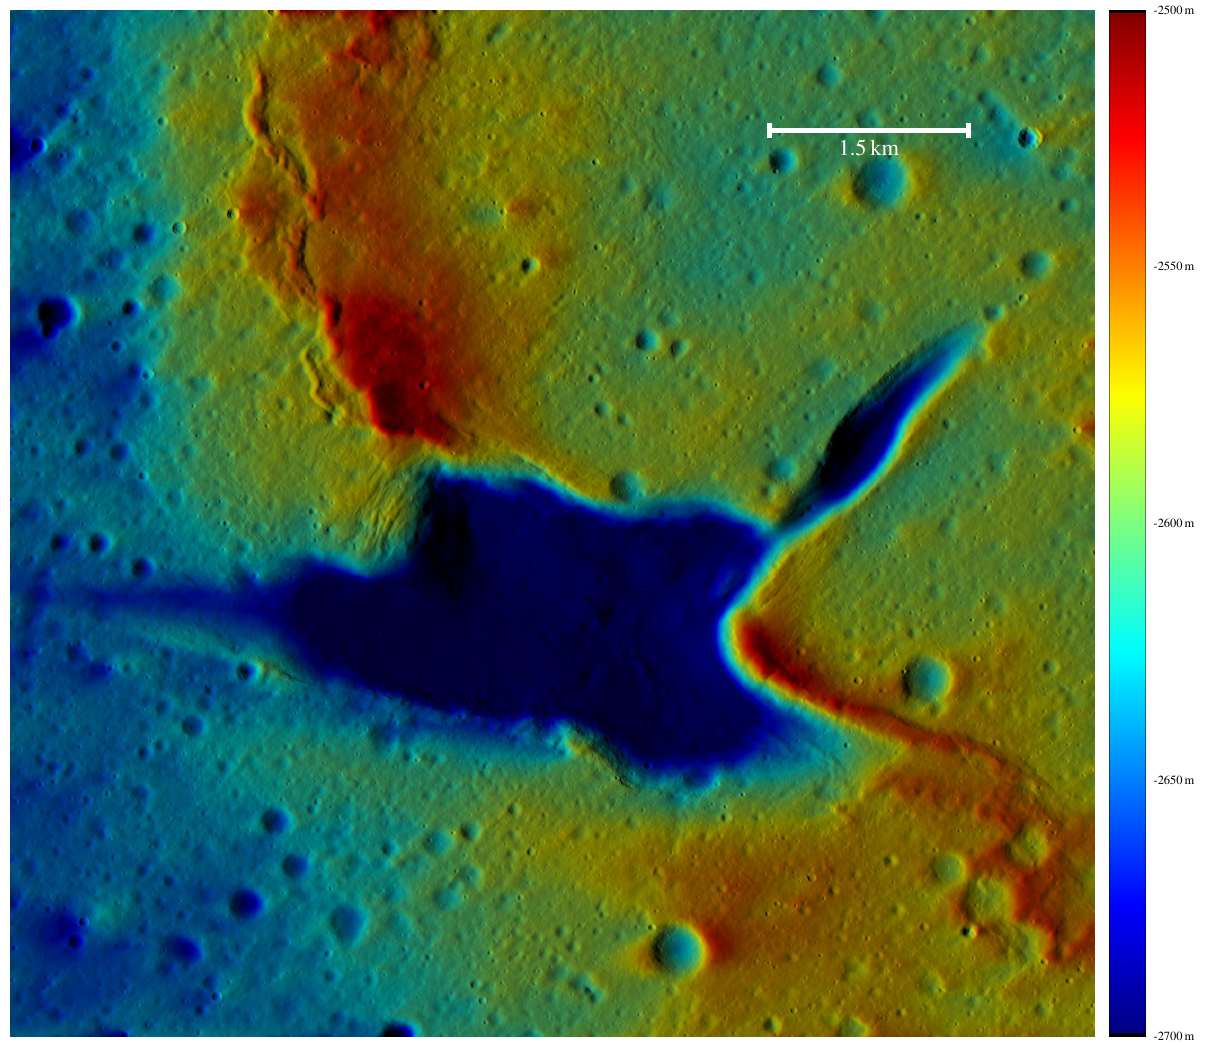
Figure 4: Close-up view of Area